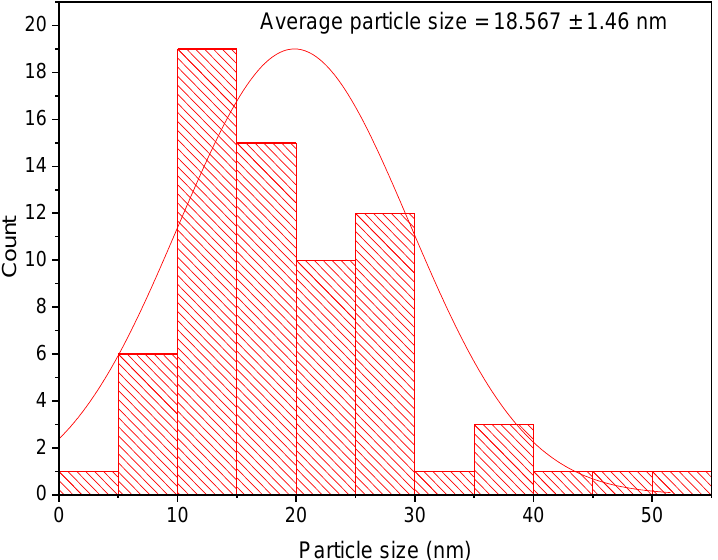
Figure 4. Particle size distribution histogram of AgNPs synthesized utilizing Punica granatum aqueous peel extract.